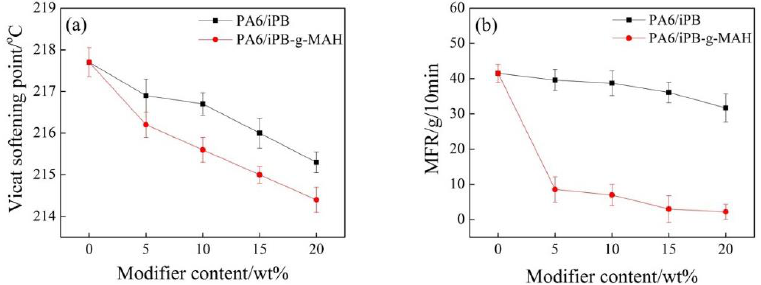
Figure 14. Effect of content of iPB and iPB-g-MAH in blends on Vicat softening point ( a ) and MFR ( b ).